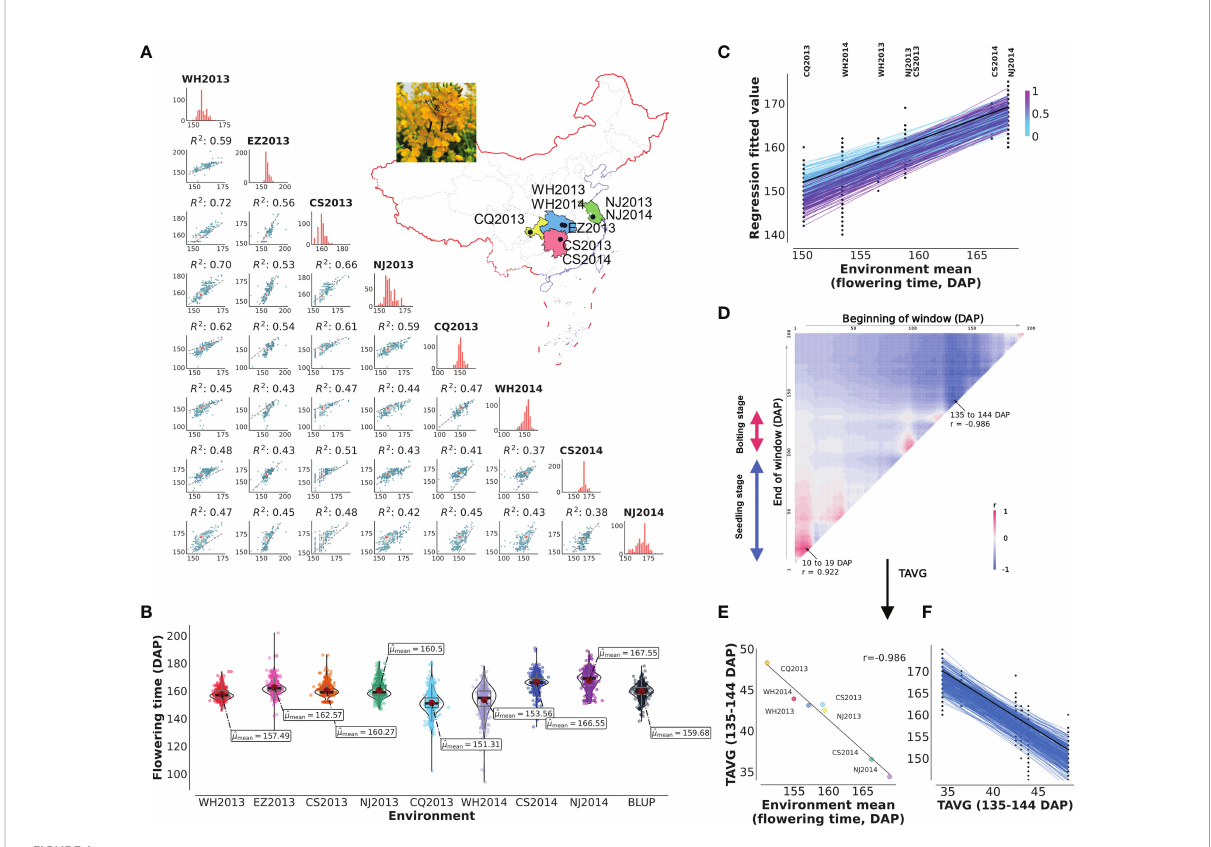
FIGURE 1 Plasticity of fl owering and reaction norm of its associated window to daily average temperature (TAVG). (A, B) Characteristics and pairwise correlations of fl owering time of 490 B napus in eight environments. WH2013, Wuhan in 2013; WH2014, Wuhan in 2014; CS2013, Changsha in 2013; CS2014, Changsha in 2014; NJ2013, Nanjing in 2013; NJ2014, Nanjing in 2014; CQ2013, Chongqing in 2013; EZ2013, Ezhou in 2013; BLUP, the best linear unbiased prediction value. (C) Reaction norm for fl owering time based on a numerical order of environmental mean. Dots are the observed fl owering time phenotypic values. The line with black color represents the ZS11 cultivar. The color of the line represents the value of the slope. (D) Search for the window to TAVG, which is highly correlated with environmental mean of fl owering time (from planting to 200 days after planting, DAP). TAVG within the window of 10 – 19 and 135 – 144 DAP was chosen and denoted as TAVG 10 – 19 and TAVG 135 – 144 . (E, F) Signi fi cant correlation and reaction norm between TAVG 135 – 144 and environmental mean of fl owering